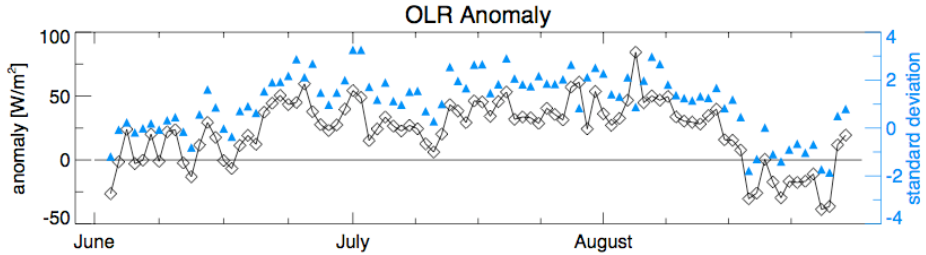
Fig. 2. AIRS OLR daily anomalies ((2010–(2003–2009 mean)) (black diamonds) and the number of standard deviations (blue triangles) averaged over (33 ◦ E–53 ◦ E, 52 ◦ N–62 ◦ N). This domain is contained within the area shown in Fig. 1c and encompasses all the radiosonde stations in western Russia.